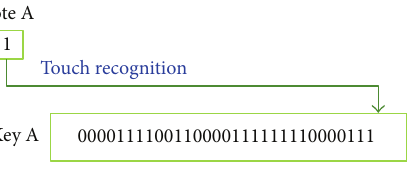
Figure 1: Generation of a single key.